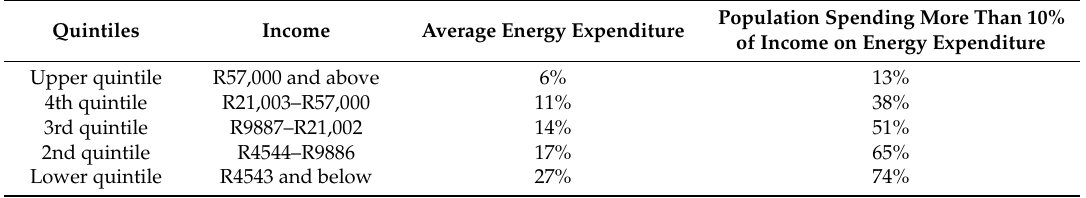
Table 1. Household income and energy expenditure in South